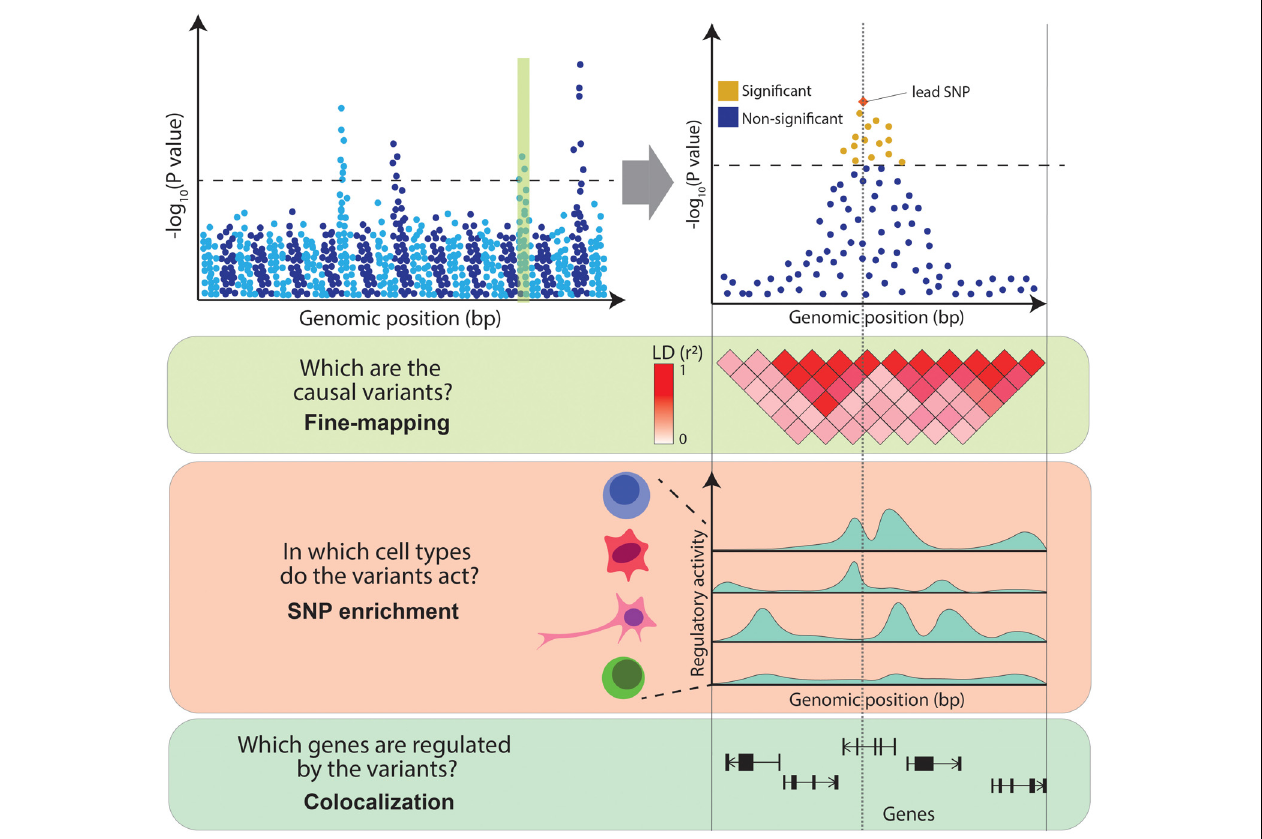
FIGURE 1 | Challenges in interpreting GWAS associations. From the top: Manhattan plot illustrates the association between genetic variants and a trait (e.g., a disease) at a genome-wide level (left panel) and within an example locus (right panel). Variants above the dotted line represent genome-wide significant associations. The panels below illustrate the main challenges in interpreting GWAS associations: high LD between variants (encoded in shades of red), variable levels of regulatory activity of the genomic regions across cell types (peaks of different heights represent different levels of activity of chromatin marks) and multiple genes within the associated